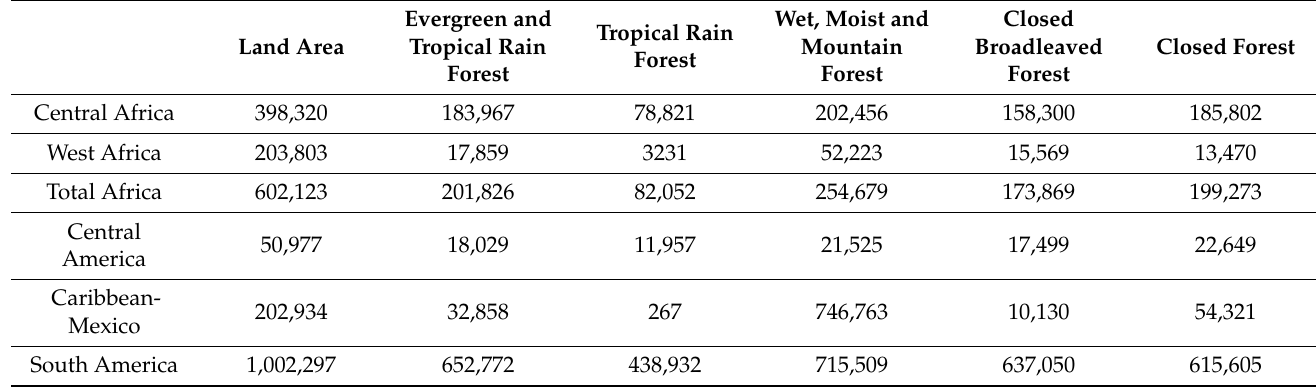
Table 1. Tropical forest area (10 3 ha) estimates of Central and West Africa Central America, Caribbean and South America from TREES project, FAO FRA 90 (FAO, 1993) and IUCN according to Mayeux (et al., 1998) [8].